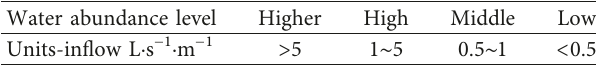
Table 3: Division of water abundance level